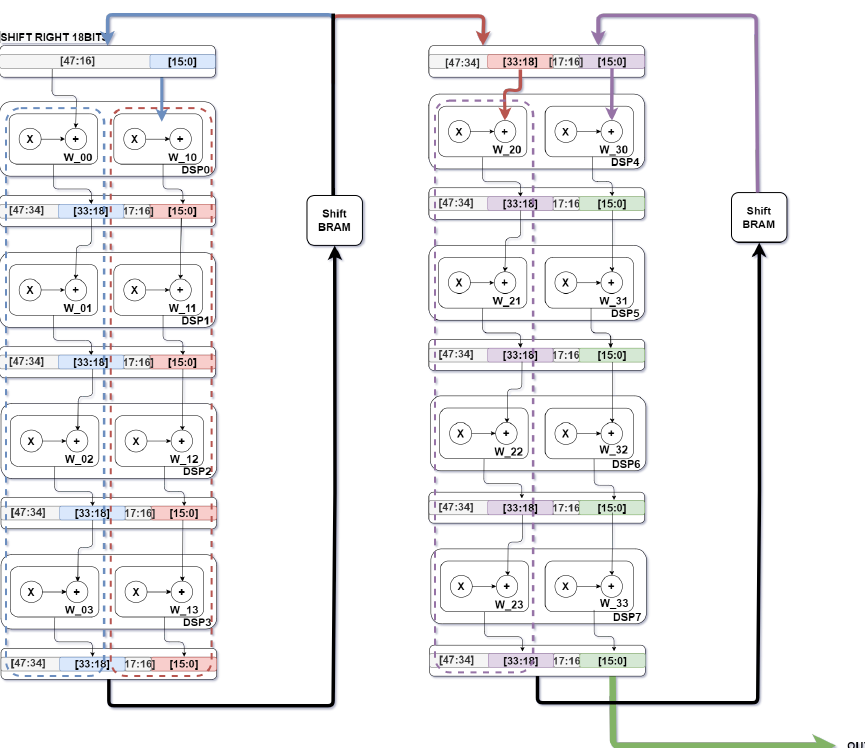
Figure 6. Block diagram for reconfigured architecture, providing two 8 bit products per DSP